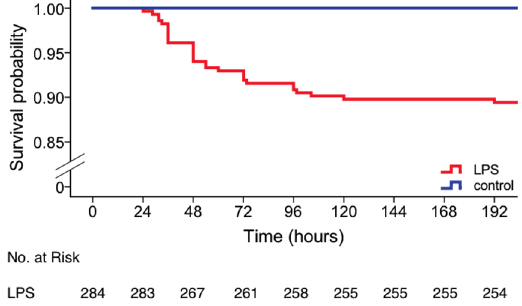
Figure 2. Kaplan-Meier curve showing cumulative survival across lipopolysaccharide (LPS)- and saline-treated animals for up to 7 days post-injection. Blue, saline-treated control mice (n = 151, n(dead) = 0); red, LPS- treated mice (n = 284, n(dead) = 30).